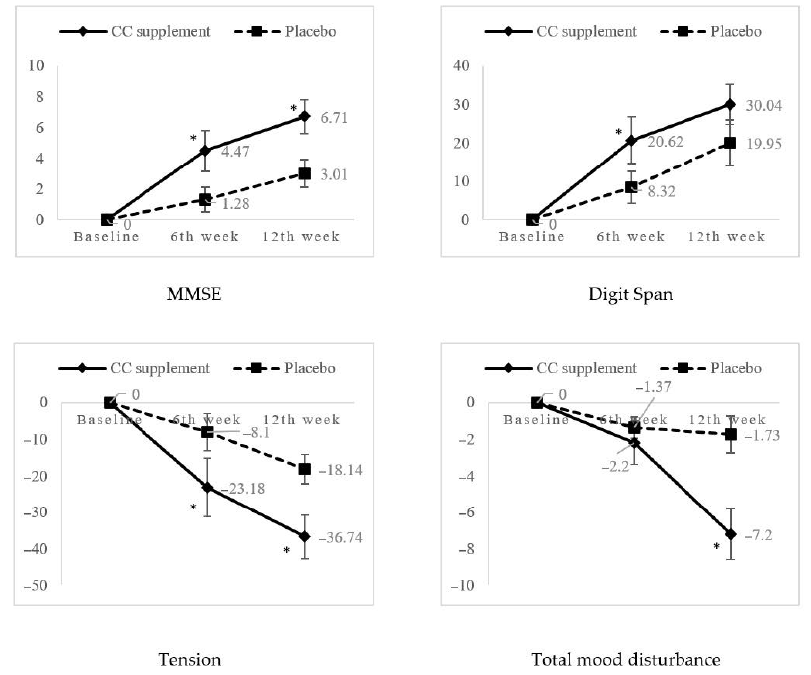
Figure 2. Percentage mean change of significant cognitive and mood parameters from baseline to 6th week and 12th week follow-ups. * Significant at p < 0.05 using independent t -test. A significant intervention effect was observed in tension ( p = 0.018, partial η 2 = 0.191, power = 0.733) and total mood disturbance ( p = 0.028, partial η 2 = 0.171, power = 0.672). The percentage of mean change for tension and total mood disturbance showed statistically significant improvement in CC supplement as compared to placebo groups at 6th week and 12th week (Figure 2).